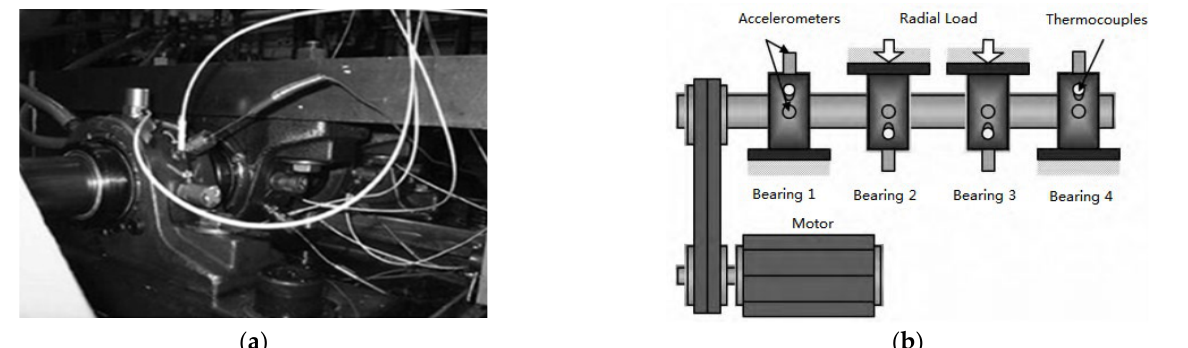
Figure 4. CWRU bearing test rig.